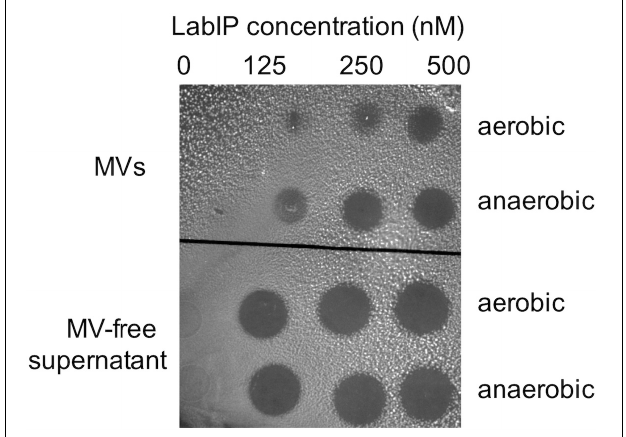
FIGURE 4 | Bacteriocin production under different conditions. Spot-on-lawn assays for bacteriocin production associated with MVs (top) or free in the supernatant (bottom) from cultures grown under aerobic or anaerobic conditions and induced with a range of LabIP concentrations, from non-induced (“0” at the left) to a maximum concentration of 500 nM at the right. L. delbrueckii subsp. lactis ATCC 15808 was used as the bacteriocin indicator strain; lawns were grown on MRS agar under anaerobic conditions. A representative image is